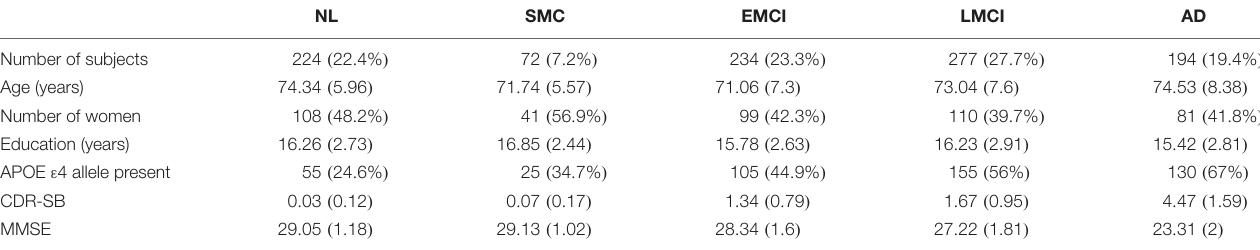
TABLE 1 | Selected demographic and clinical characteristics of 1001 ADNI participants at baseline.